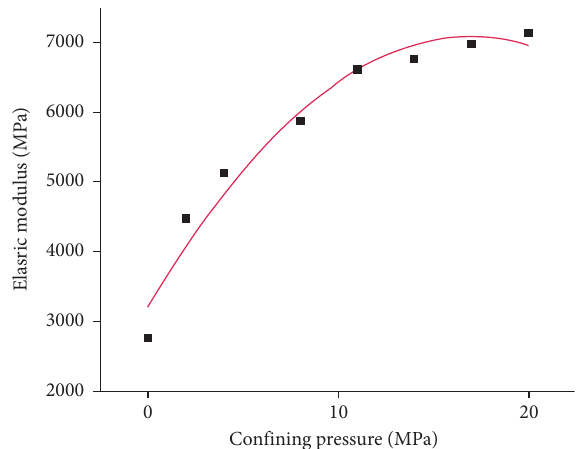
Figure 3: Relationship between elastic modulus and confining pressure of coal